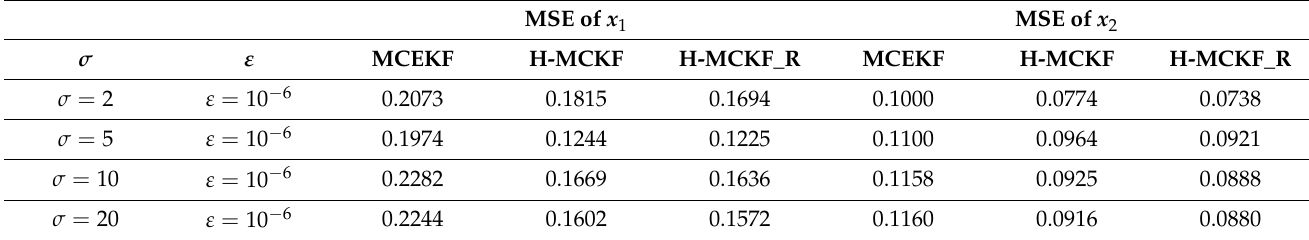
Table 1. The mean squared error using the three methods in case 1.